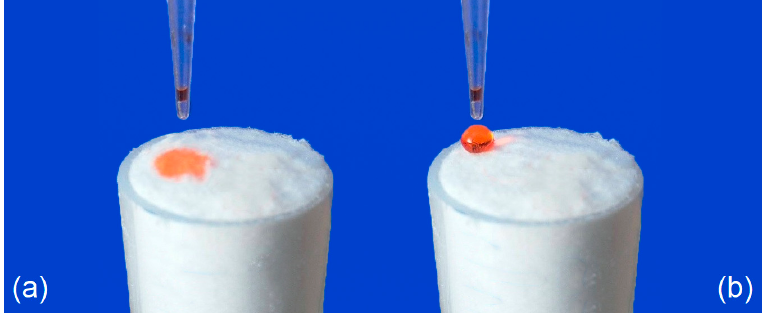
Figure 3. Comparison of surface wettability of compressed ( a ) untreated and ( b ) functionalized cellulose (sample 18) by optimized functionalization process.